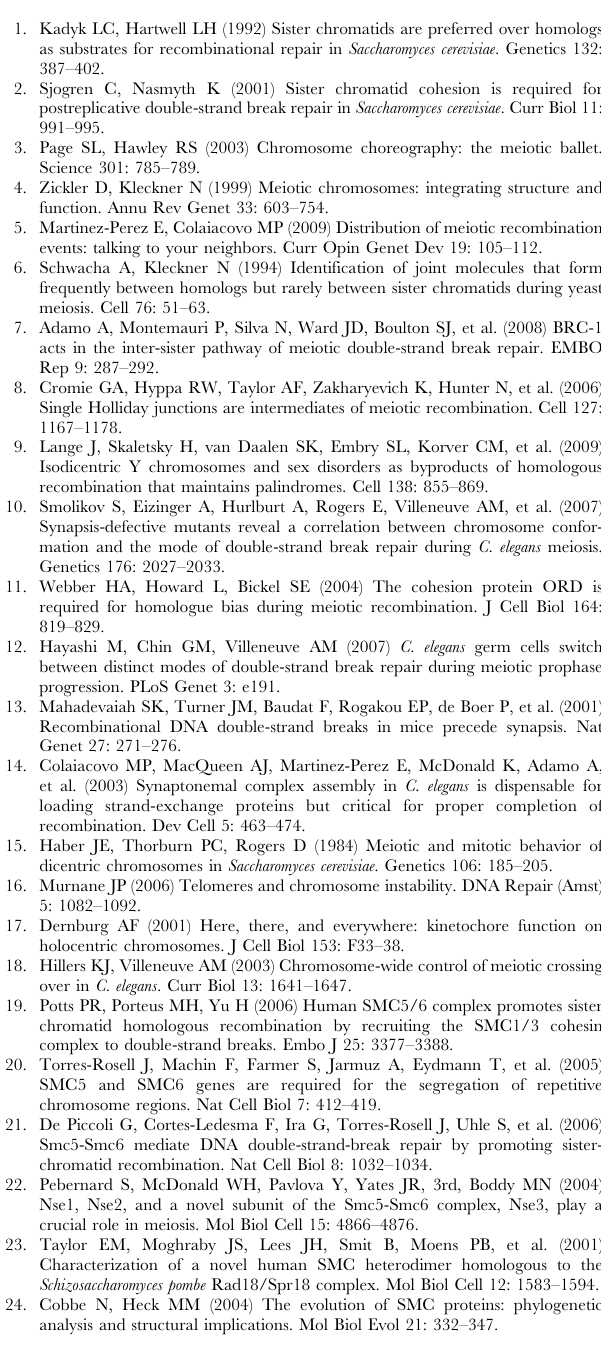
Table S5 Proportion of oocytes with one or more chromosome fragments at diakinesis. Statistical comparisons were performed using the Fisher’s Exact Test [4]. [4] Agresti A (1992) A survey of exact inference for contingency tables. Statistical Science